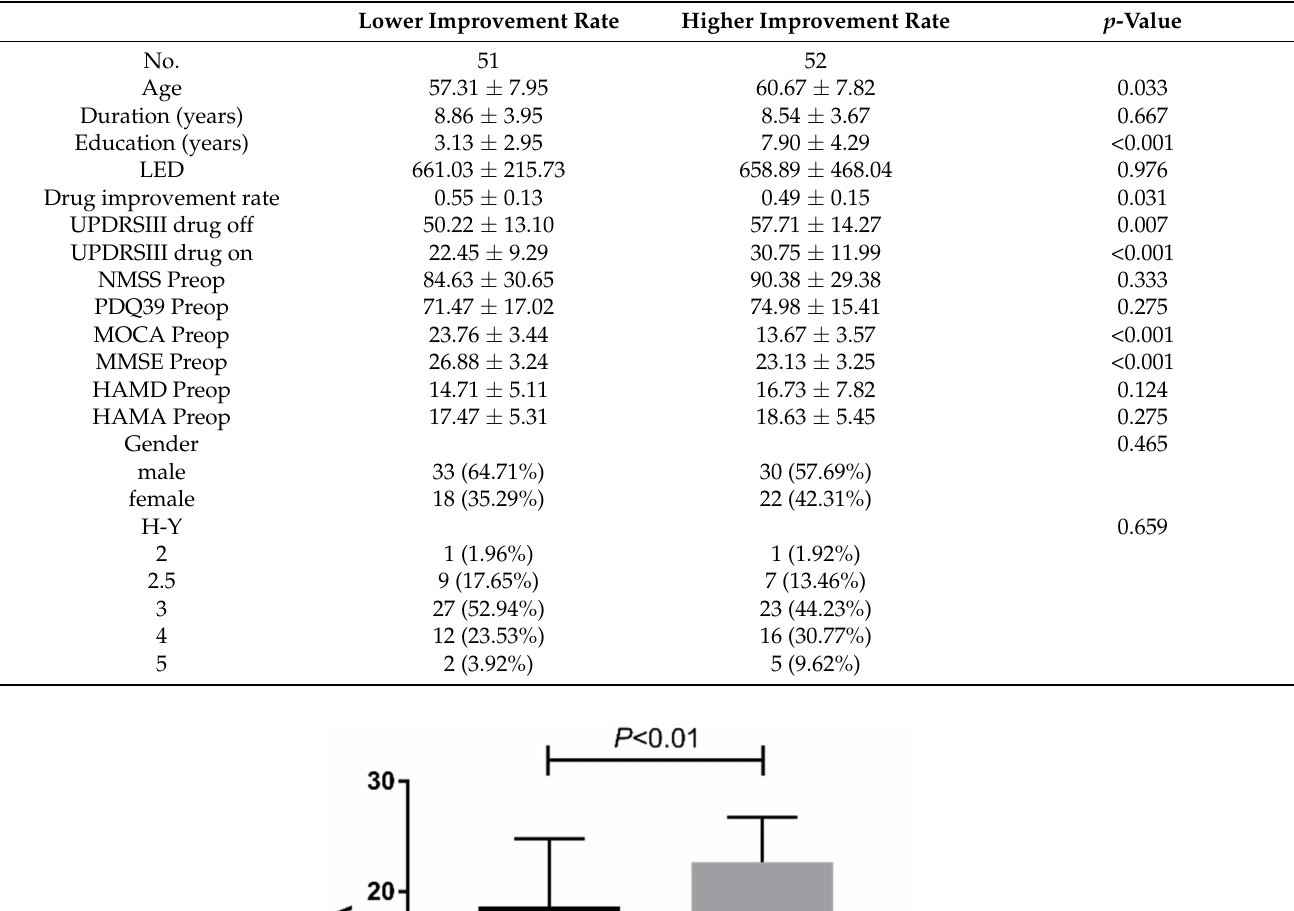
Table 1. Comparison between patients with higher improvement rate of cognitive state and those with lower rate of improvement.